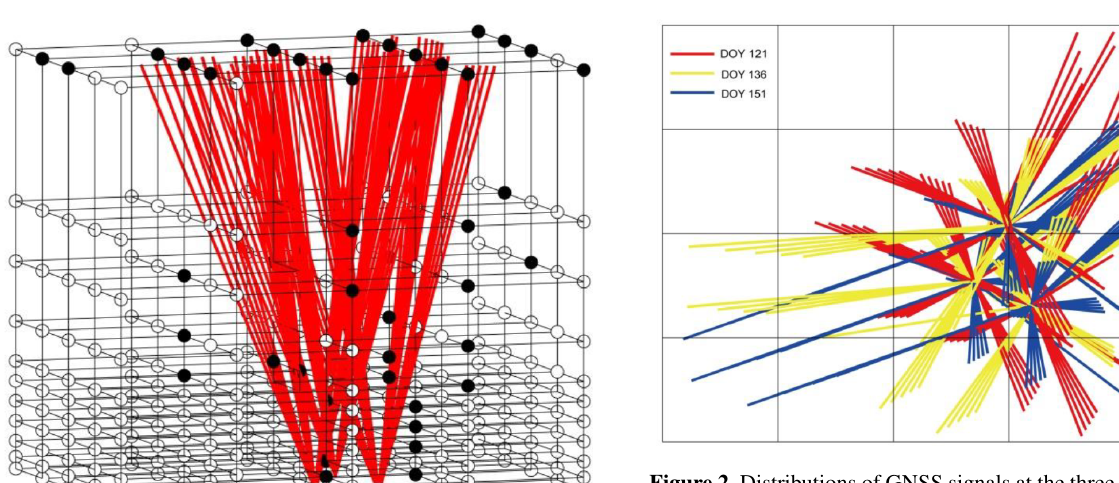
Figure 2. Distributions of GNSS signals at the three stations shown in Fig. 1 on the top plane of the tomographic field with the sampling rate of 30s at 00:00UTC on 1, 16 and 31 May